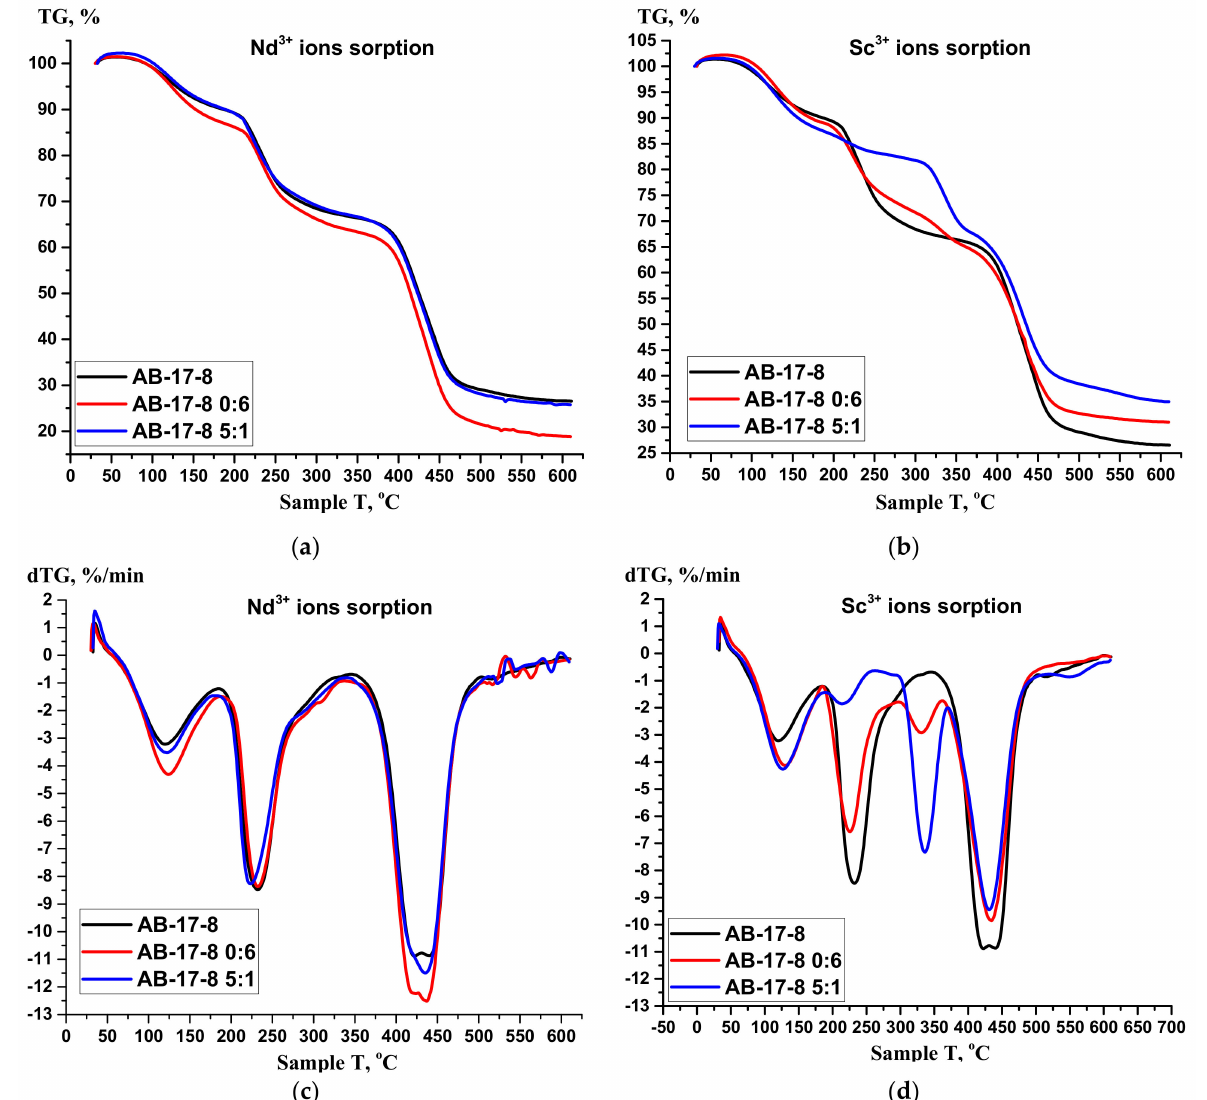
Figure 13. TGA curves of ( a , b ) mass loss and ( c , d ) rate of mass loss of